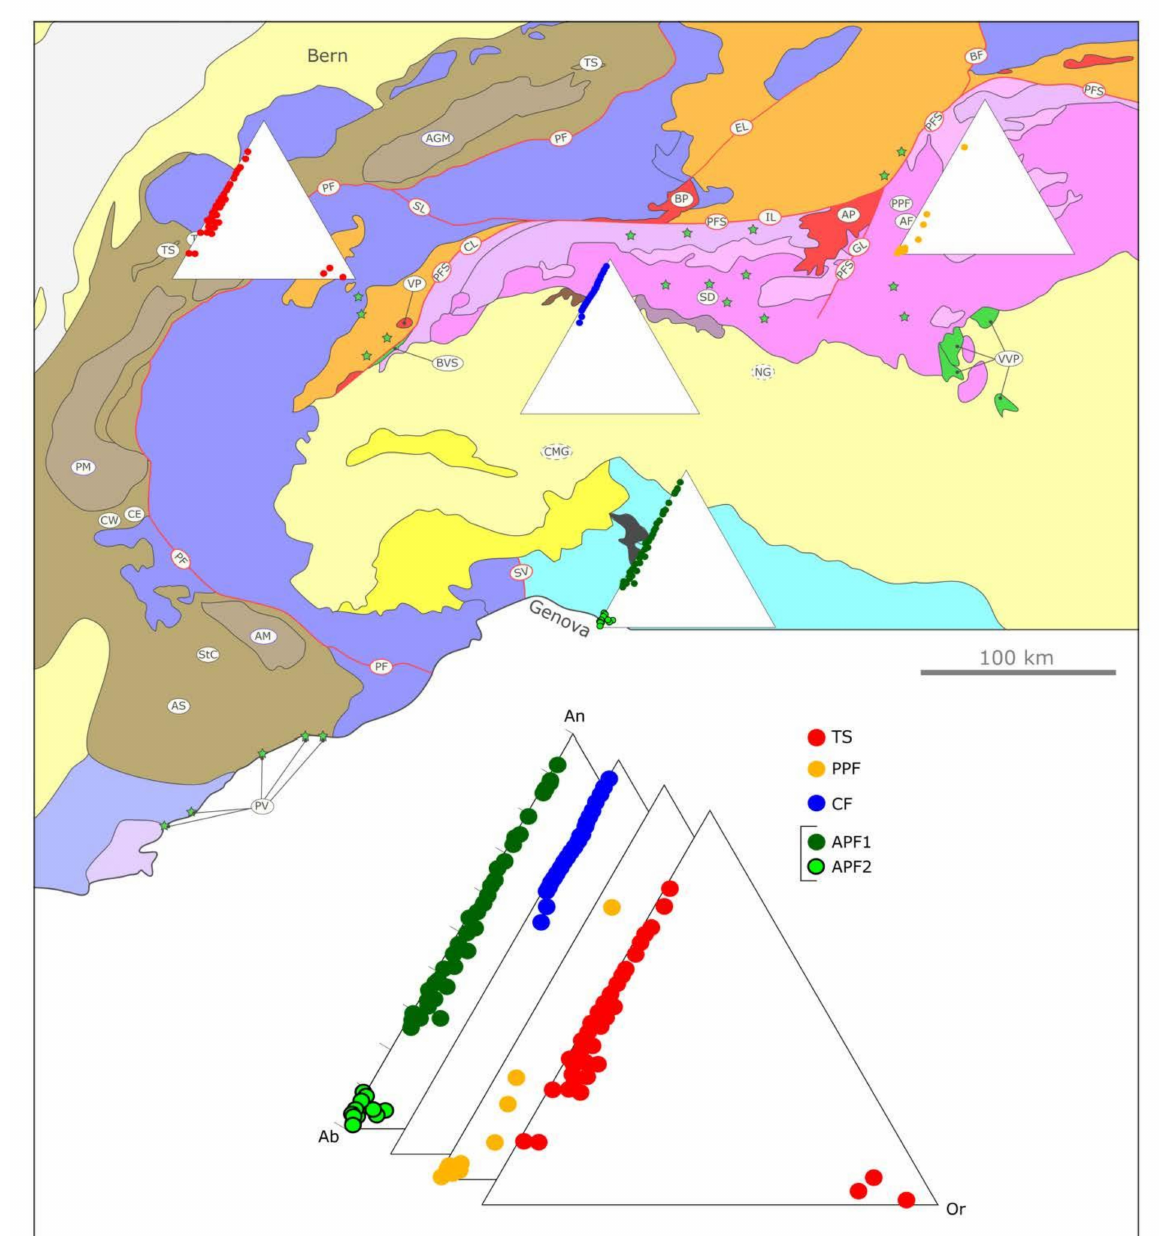
Figure 4. Compositions of feldspar crystals. TS = Taveyanne Sandstones [31]; PPF = Ponte Pi à Formation [32]; CF = Cibrone Formation (this work); APF = Val d’Aveto–Petrignacola Formation ( 1 ) [36] and ( 2 ) (this work on pyroclastic density current deposit described by